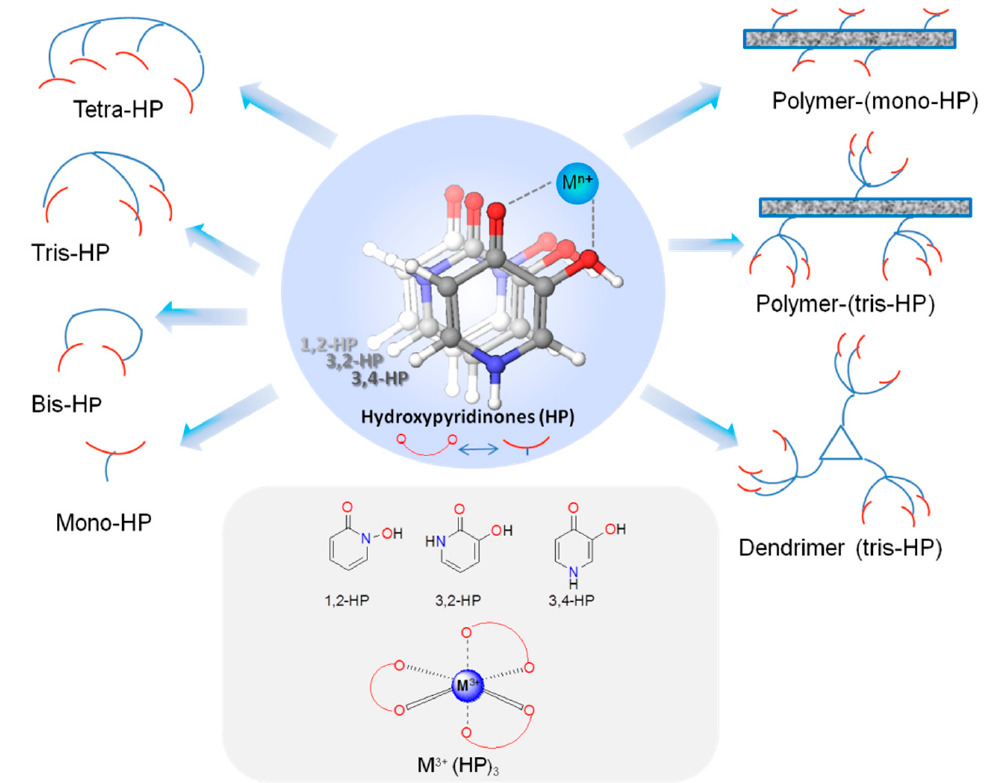
Figure 1. Schematic illustration of the structures of hydroxypyridinone (HP)-based metal chelators (3,4-HP, 3,2-HP, 1,2-HP), from their mono-bidentate (mono-HP) to building blocks of multi-HP ligands, and also typical HP-metal (M 3+ ) coordination mode.